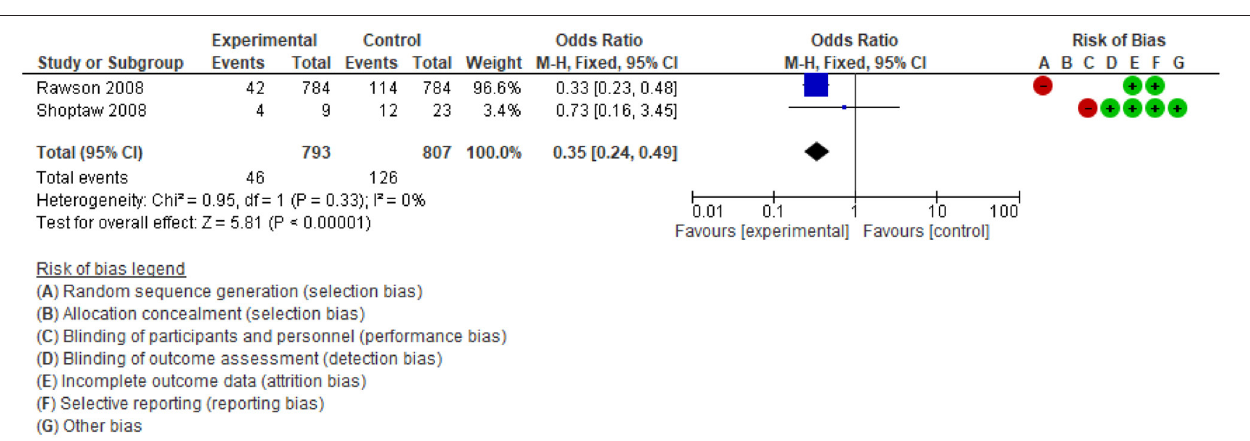
FIGURE 7 | Comparison of percentage Injection drug at the end of